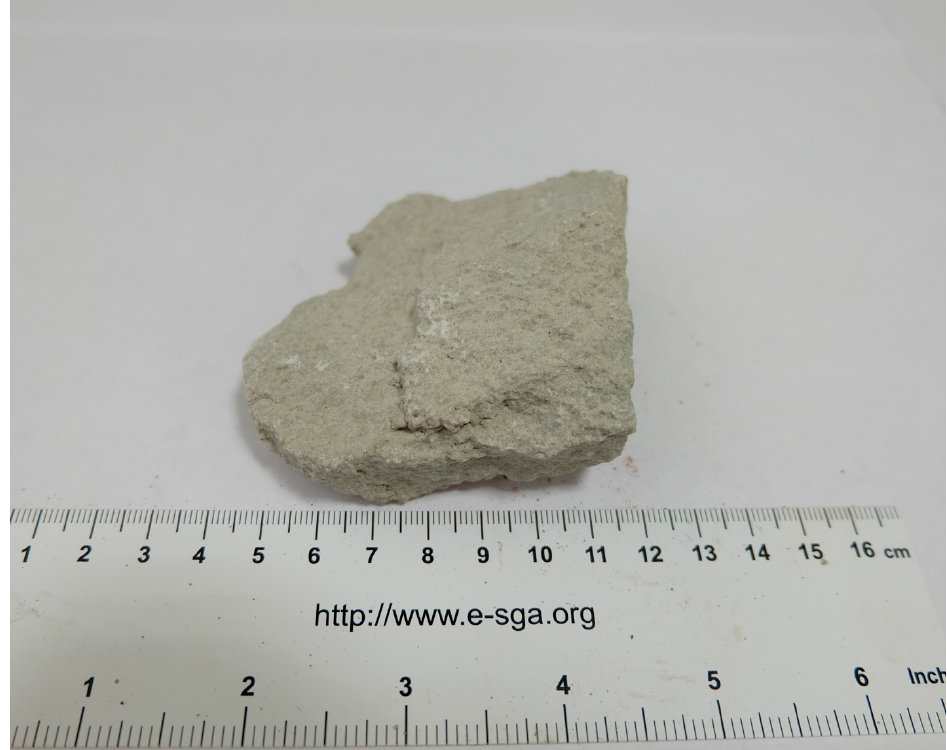
Figure A3. Gray sandstone with calcareous and clay cement (sample ID GGS _2_10_20), overlying Middle Carboniferous rocks, Ursug suite ( C 2 ur ), Lomonosov diamond deposit.